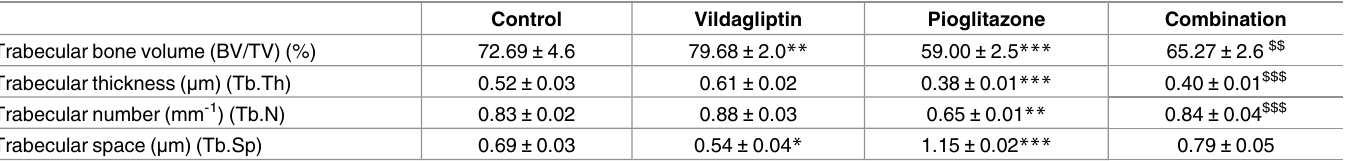
Table 1. Bone histomorphometric results in ZDF